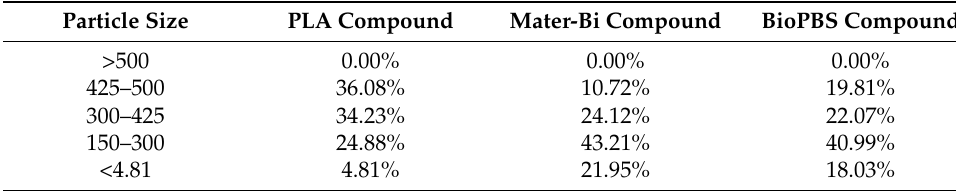
Table 6. Particle size distribution (ISO